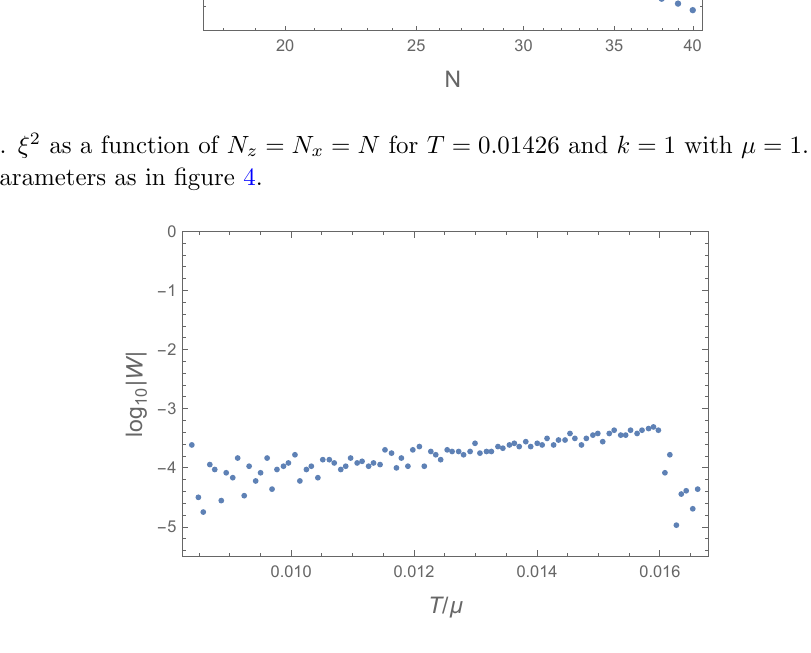
Figure 17 . Numerical check of the (cid:12)rst law W for a set of solutions corresponding to a branch with (cid:12)xed k=(cid:22) = 1. We choose the same parameters as (cid:12)gure